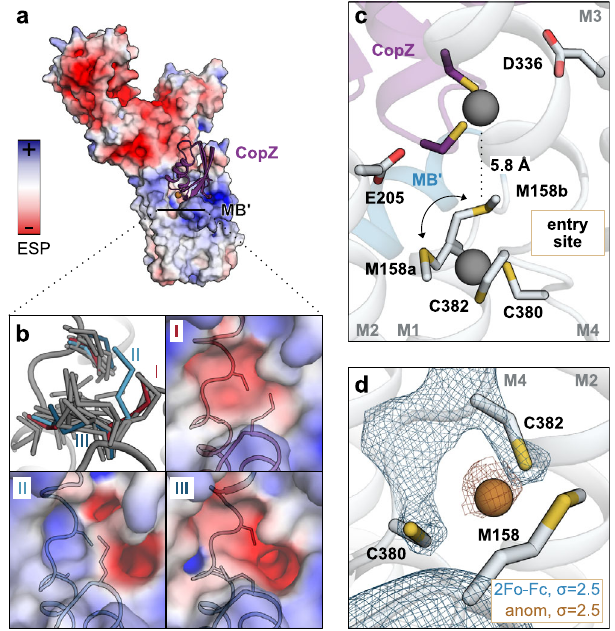
Fig. 4 | Cu + entry. a Electrostatic surface representation of the determined CopA structure. CopZ docking was performed with pyDockWEB 45 using a homology model of the C-terminal part of AfCopZ (see Methods for details). b Ensemble re fi nement around the Cu + entry site yielded multiple possible orientations of the M158sidechain.Theelectrostaticsurfaceisshownforthreeselectedensembles(I- III), illustrating that modest reorientations have a major impact. c Model for Cu + uptake based on CopZ docking and ensemble re fi nement. A transient Cu + uptake site islikely formed by the Cu + -coordinating residues (the so-called CxxC motif) of CopZ and M158, adopting an upward-facing side chain conformation similar to ensemble II. Cu + transfer from CopZ directly to M158 is possible, likely without involvementofE205andD336thatwerepreviouslyproposedtobeinvolvedinion uptake 16,24 . ReorientationofM158 leads to formation ofthe transient Cu + entrysite detected in our data together with C380 and C382 of the CPC motif in M4. d Anomalous data collected at the Cu edge compatible with the presence of a Cu + ion bound to C382 at the entry site. The fi nal 2Fo-Fc and anomalous difference maps are shown in blue and brown mesh,